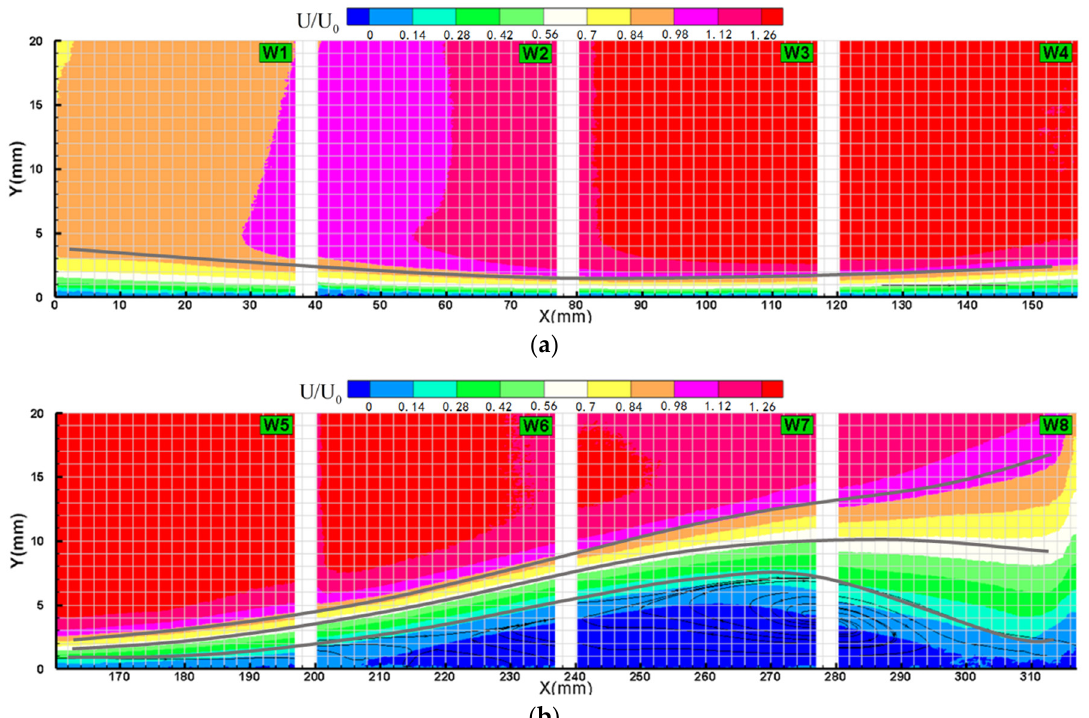
Figure 5. Time mean streamwise velocity: ( a ) the fore part of the flow field; and ( b ) the rear part of the flow field.